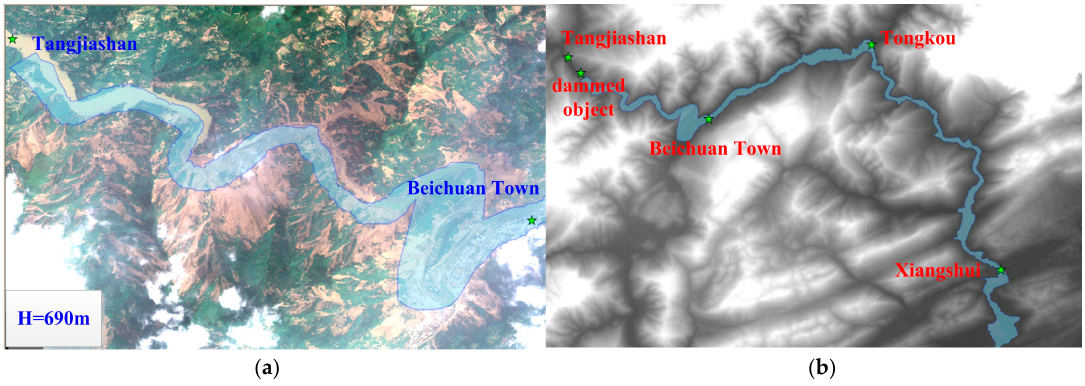
Figure 8. Potential impact area of the dammed lake downstream ( H = 700 m). ( a ) Partial view of the submerged area; ( b ) Global view of the submerged area.